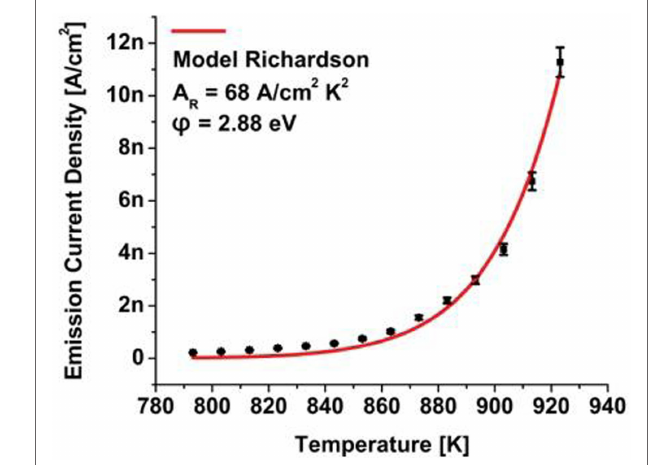
FIGURE 4 | Thermionic electron emission from a high-pressure, high temperature (100) nitrogen-doped, single-crystal diamond sample with negative electron affinity surface properties induced by hydrogen